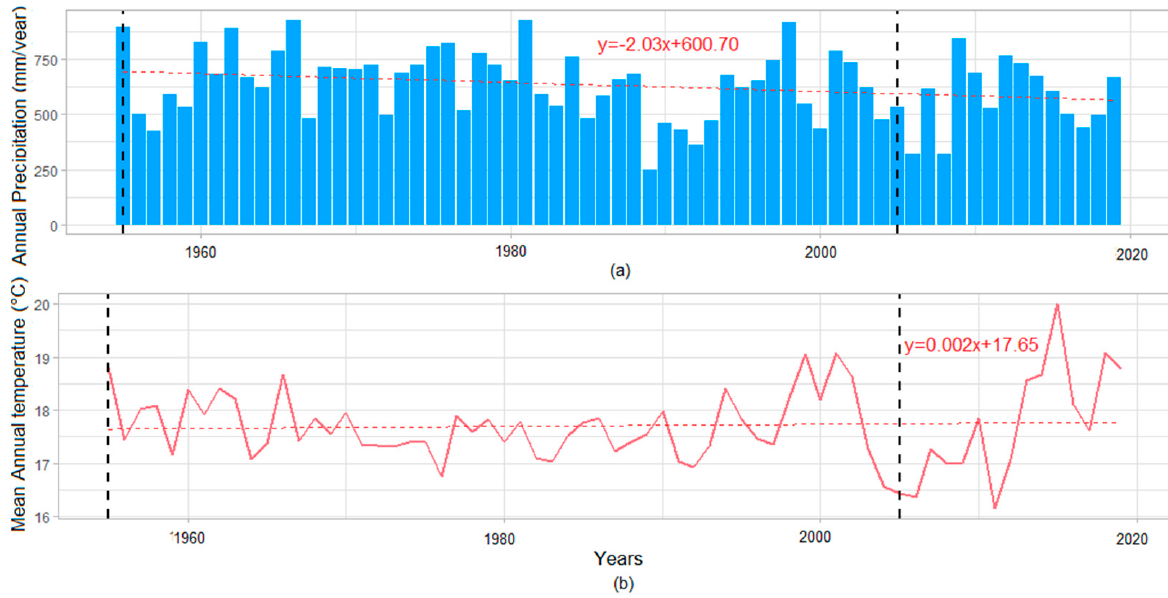
Figure 2. ( a ) Annual rainfall over Tsiknias basin from Agia Paraskevi station (95 m); and ( b ) mean annual temperature in Tsiknias basin from Agia Paraskevi station. Vertical black dashed lines delimit the period of 1955–2005, while the horizontal dashed red line corresponds to the trend.